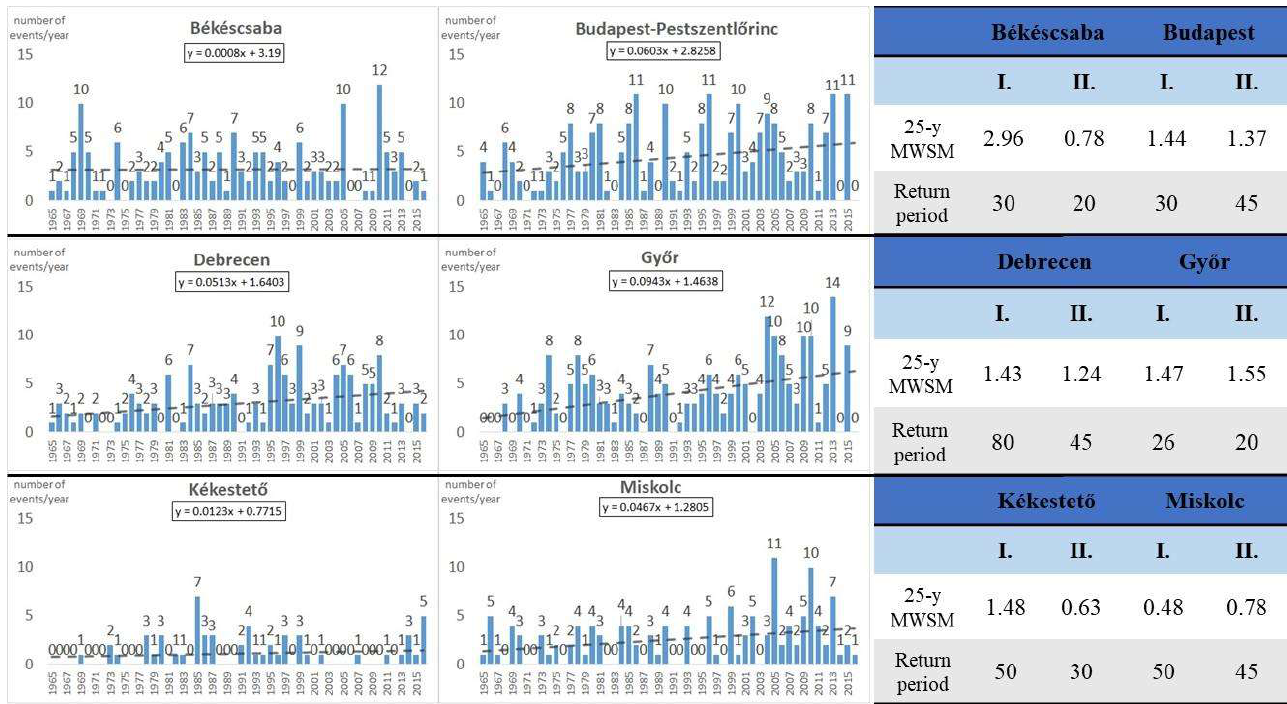
Figure 7. Annual Number of Cases (ANC) of wet snow events between 1965–2016 with a linear trend line (dotted line) and its equation ( left ) and the 25-year Maximum Wet Snow Mass (MWSM) (kg·m −1 ) and its Return period in the 1965–1990 period (Column I.) and in the 1991–2016 period (Column II.) ( right ) in Békéscsaba, Budapest-Pestszentlőrinc, Debrecen, Győr, Kékestető, Miskolc.